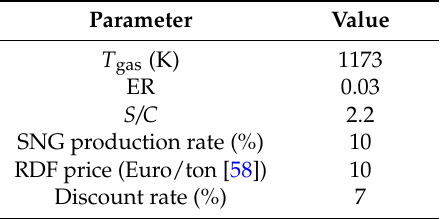
Table 2. System parameters for the basic scenario.